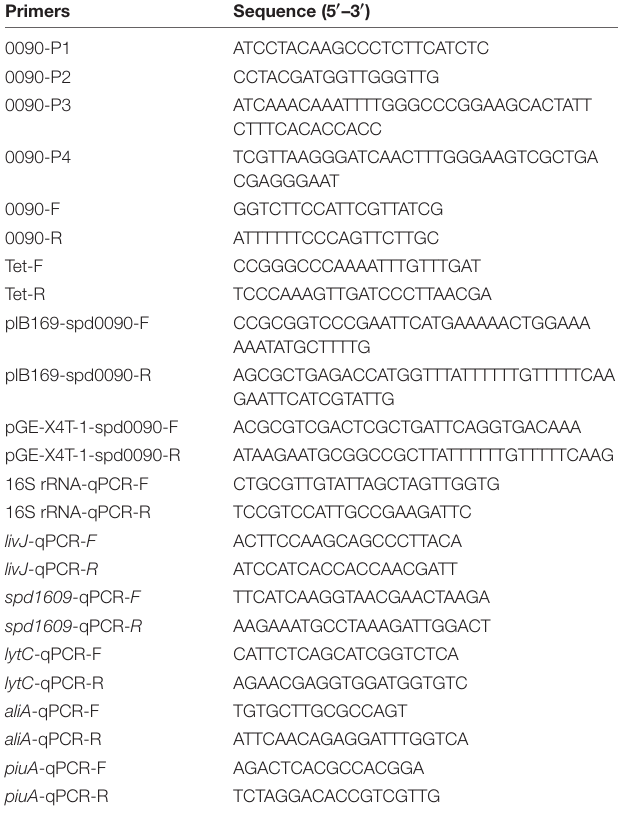
TABLE 2 | The primer sequences used in this